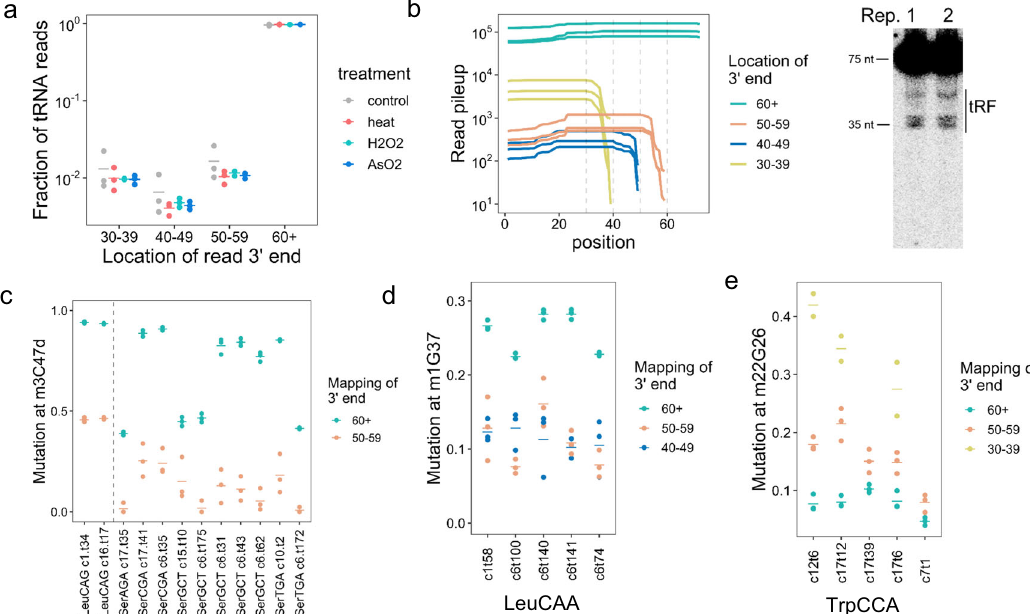
Fig. 6 Analysis of tRNA fragment biogenesis and tRNA modi fi cation. MSR-seq was performed in biological triplicates ( n = 3) for each condition. a Total count of tRNA fragment (tRF) relative to full-length tRNA in all four conditions. 60 + tRNA are considered full-length tRNAs; replicates are shown as points, mean of replicates is shown as a bar. b Read pileup of the most abundant tRF Gly (CCC) isodecoder showing the amount of tRFs with 3 ′ ends in 30 – 39 (anticodon loop), 40 – 49 (variable loop), and 50 – 59 (T loop) in unstressed control samples. The gel shows Northern blot tRF Gly (CCC) validation. Data for n = 2 independent biological replicates are shown. Source data are provided as a Source Data fi le. c Comparing mutation fraction of m 3 C47d in tRF versus full-length cognate tRNA for tRNA Leu (CAG) and tRNA Ser isodecoders in unstressed controls. d Comparing mutation fraction of m 1 G37 in tRF versus full- length cognate tRNA for tRNA Leu (CAA) isodecoders in unstressed controls. e Comparing mutation fraction of m 2 2 G26 in tRF versus full-length cognate tRNA for tRNA Trp isodecoders in unstressed